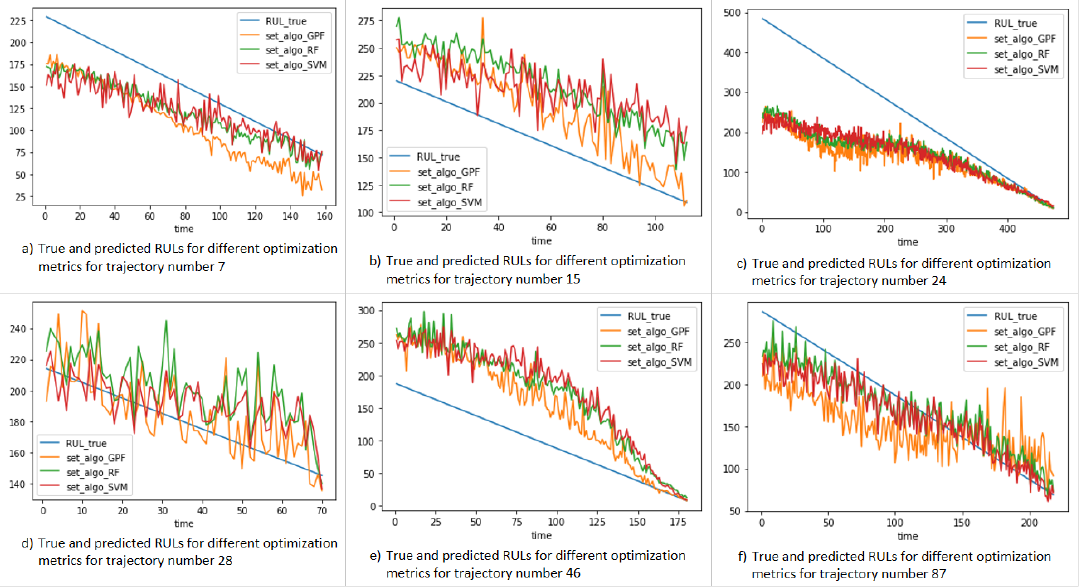
Figure 12. True and predicted value on dataset FD003 for six different trajectories when using the GPF, RF, and